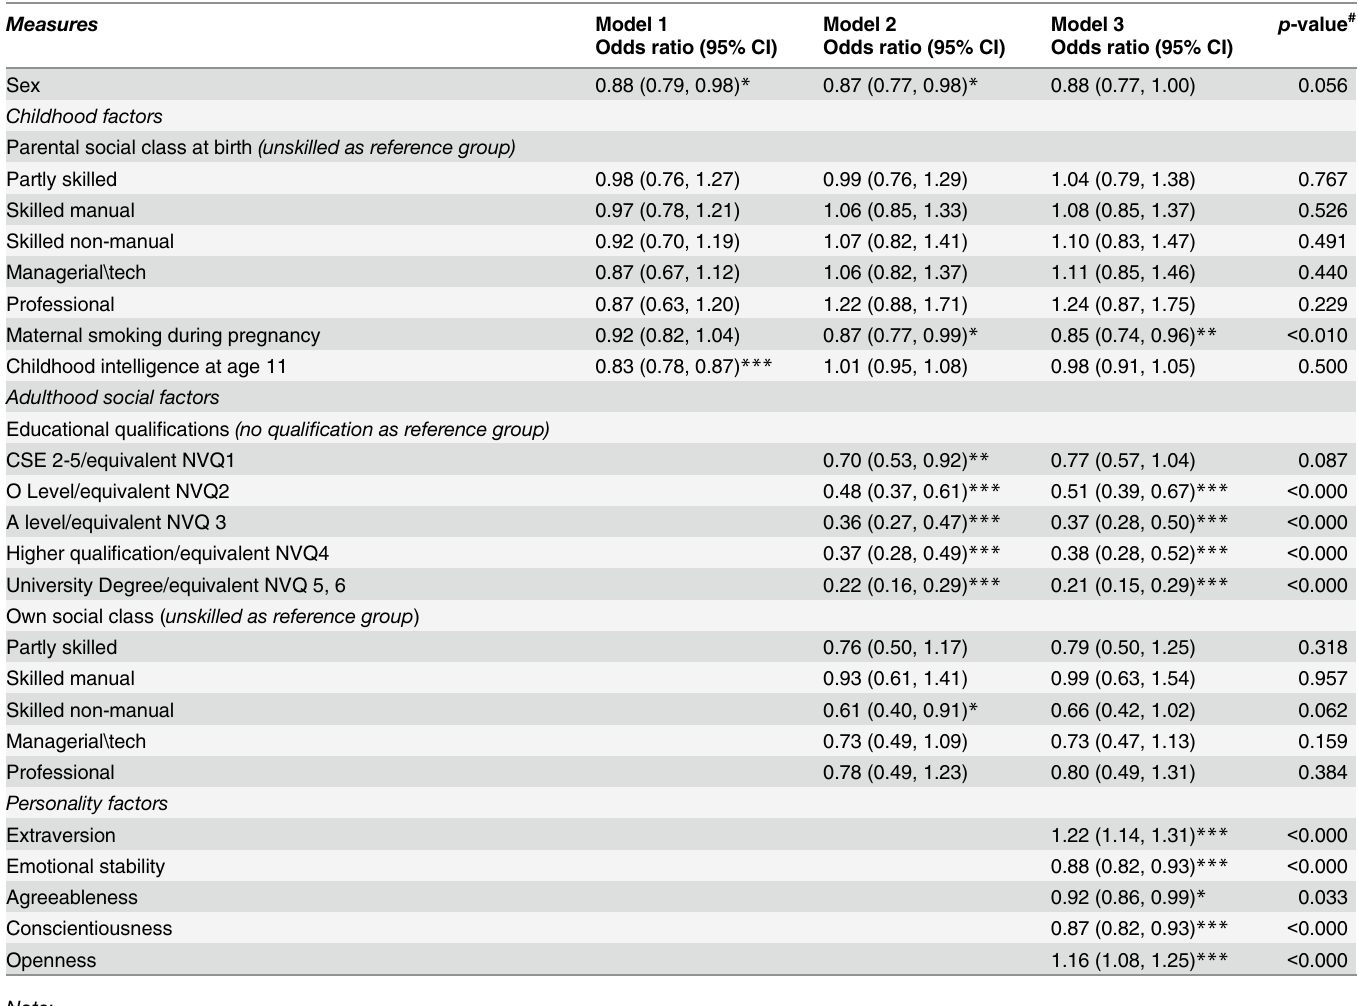
Table 2. Odds ratios (95% CI) for lifelong tobacco use measured at age 50, according to childhood and adulthood